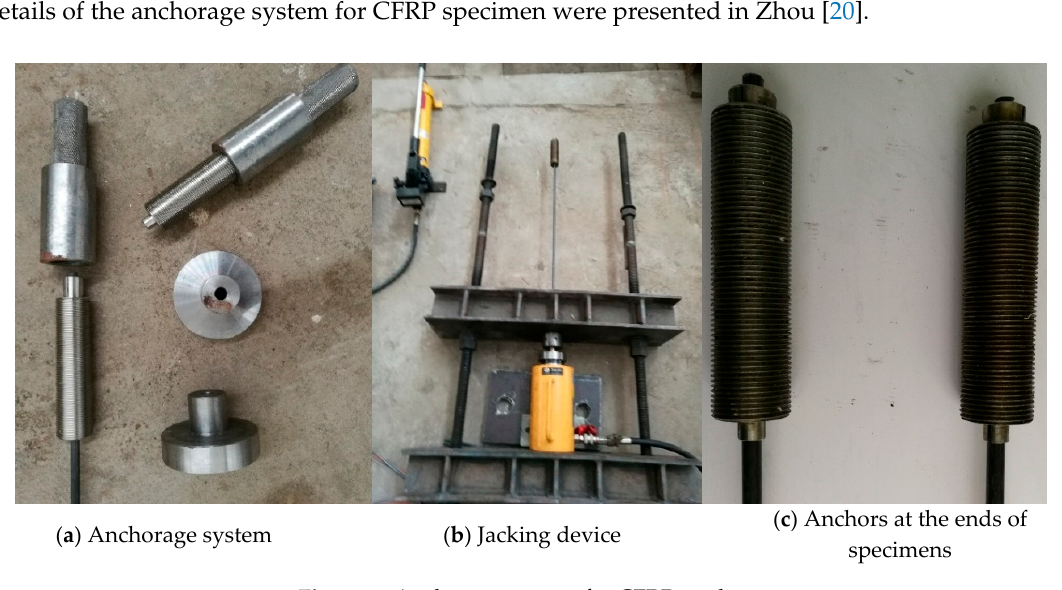
Figure 1. Anchorage system for CFRP tendons.